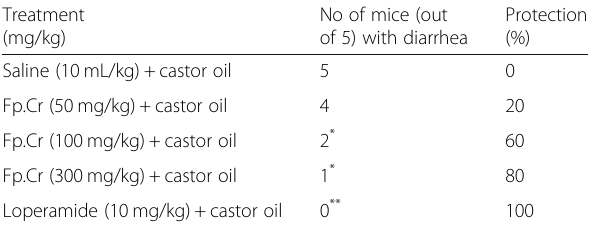
Table 1 Effect of the Ficus palmata crude extract (Fp.Cr) and loperamide against castor oil induced diarrhea in mice Treatment (mg/kg)